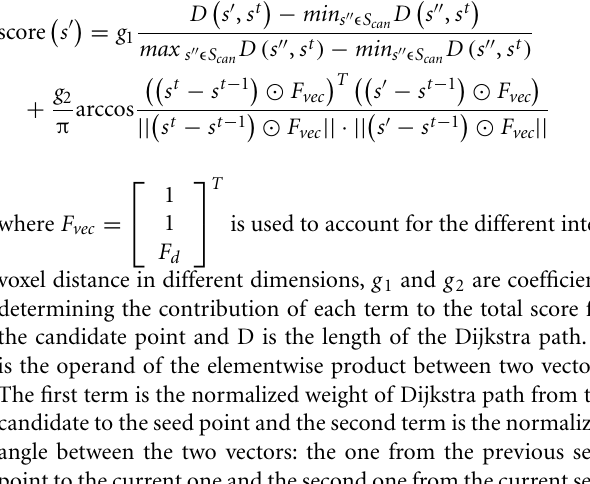
Frontiers in Neural